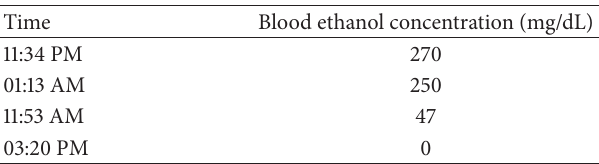
Table 1: Blood ethanol concentration of 5-week-old male showing time of laboratory analysis.